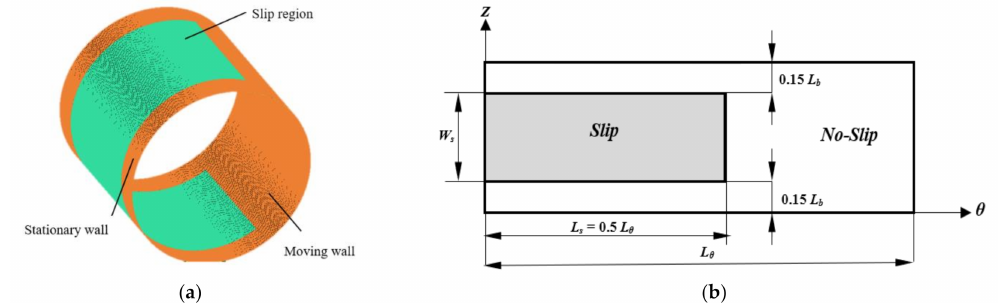
Figure 2. Slip/no-slip configuration for journal bearing studied, ( a ) in isometric view, ( b ) in top view.